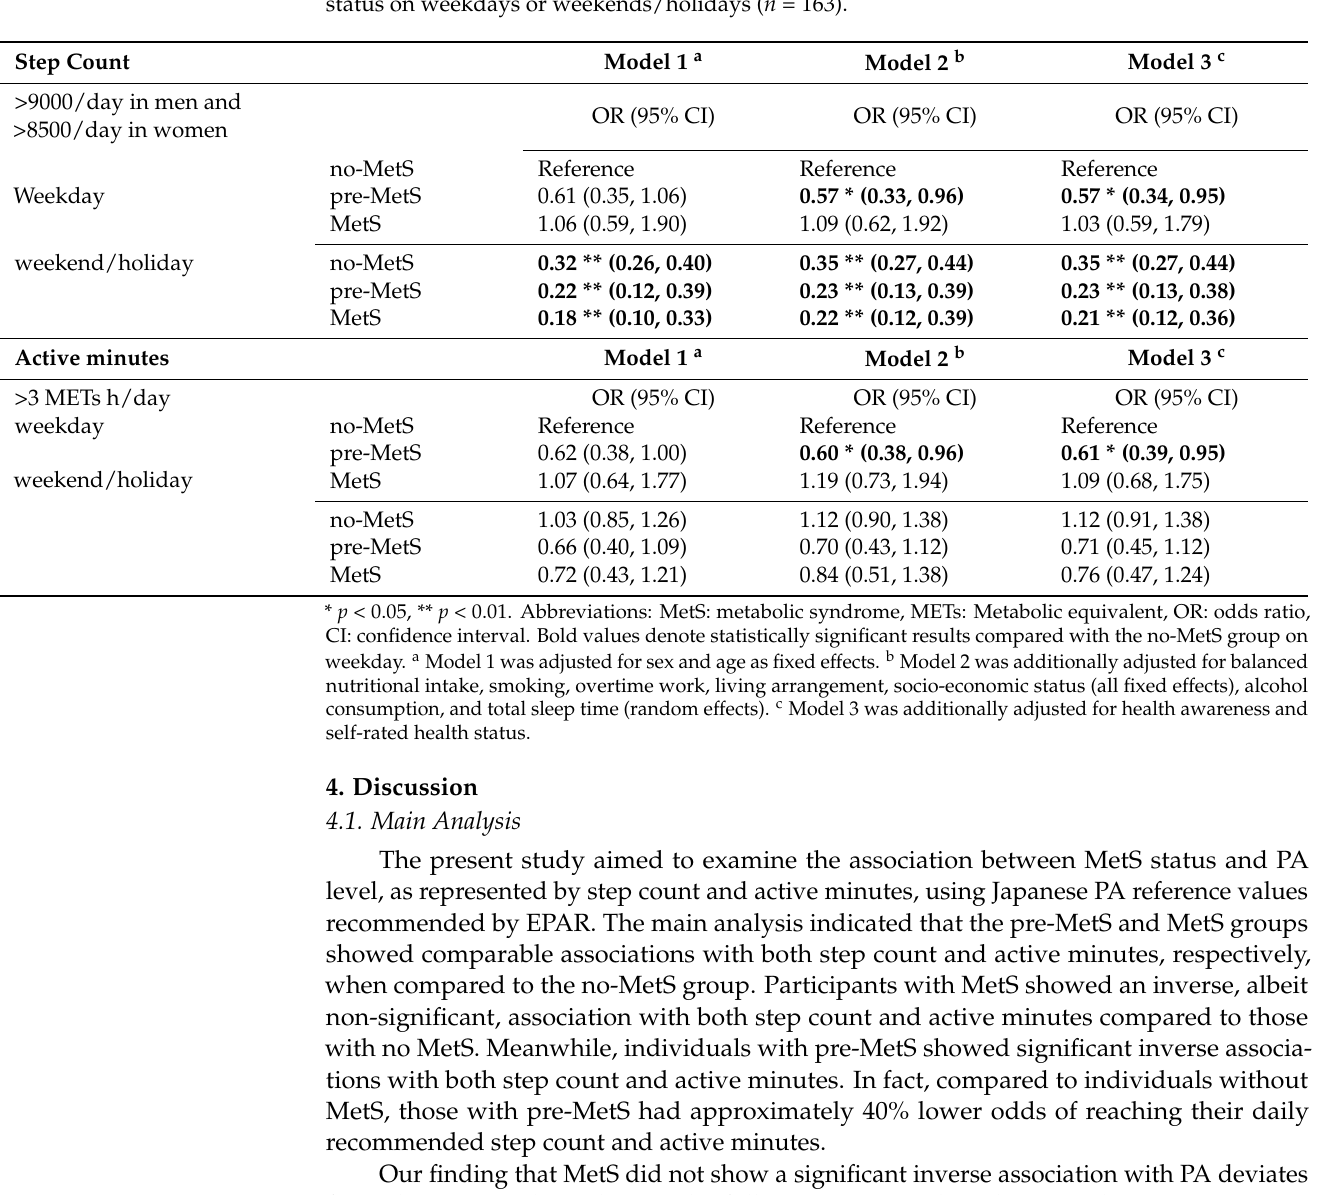
Table 3. Odds ratios of achieving the recommended physical activity level by metabolic syndrome status on weekdays or weekends/holidays ( n =